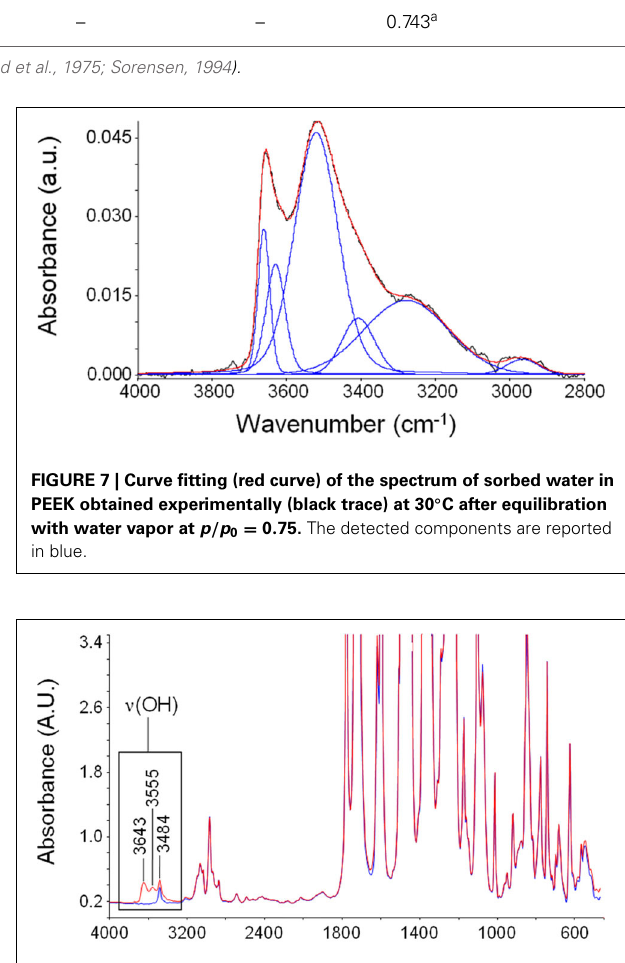
Table 6 | NRHB parameters for PEI. Polymer